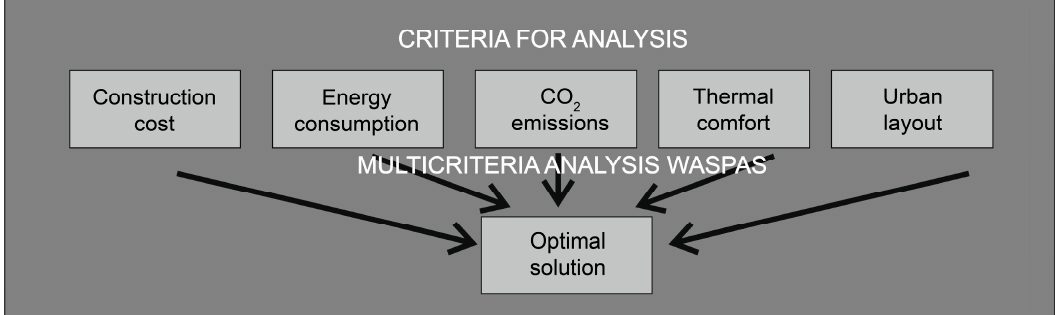
Figure 2. Criteria adopted for the WASPAS analysis.